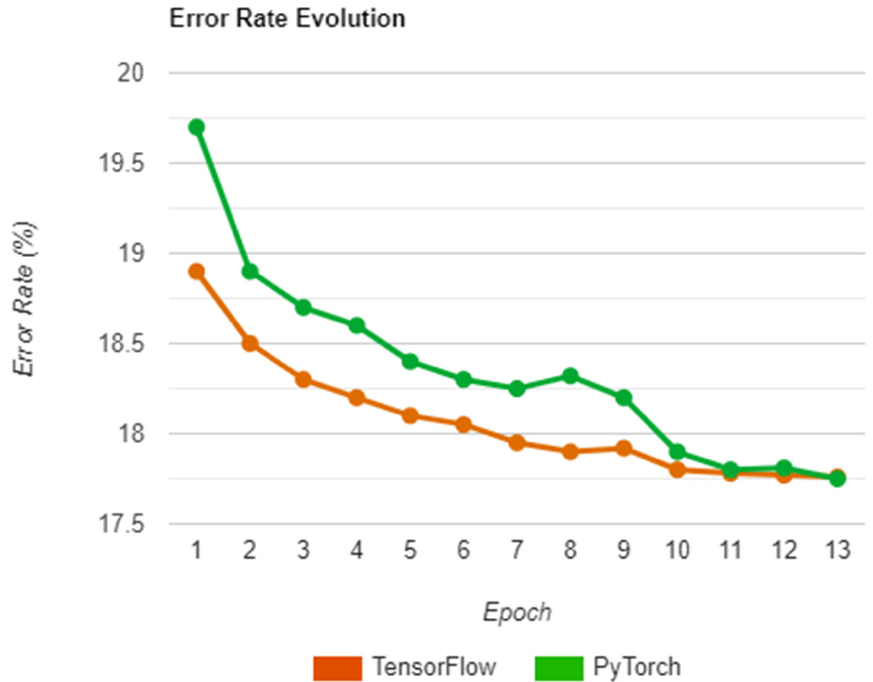
Figure 13. Error rate evolution over the epochs.